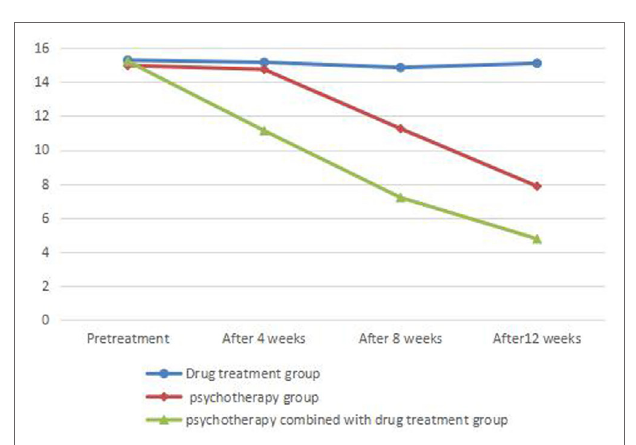
FigUre 1 | Comparison of HAMD scores before and after treatment in each group.